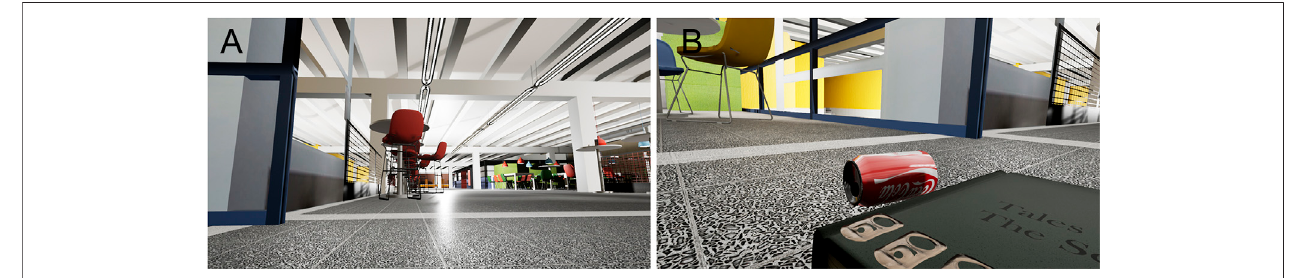
FIGURE 2 | A screenshot of the VE from Study 1 from the subject ’ s perspective when looking forward and upward with book and tabs below the line of sight (A) and when looking left (B) (Pouke et al., 2020).